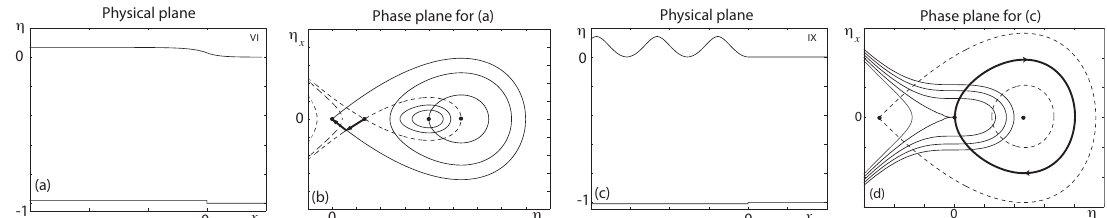
Figure 7. Flow over a step up and step down in the topography [54]. The solid and broken curves correspond to the two phase planes for x > 0 with σ = 0 and x < 0 with σ = h , respectively. ( a , b ) Supercritical flow type VI, for F > 1 and h > 0. ( c , d ) Critical flow type IX, for F = 1 and h <